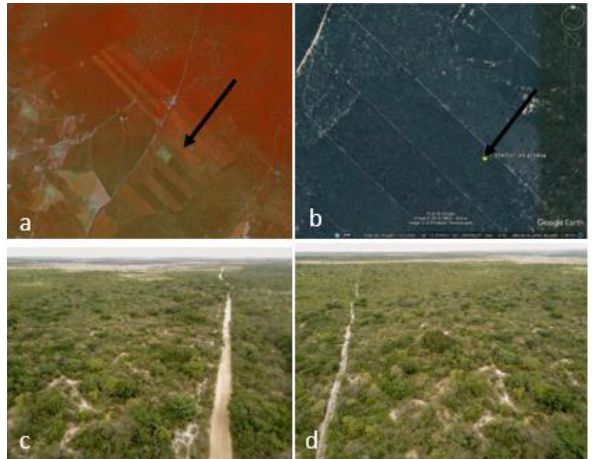
Figure 8. An example of Caatinga native vegetation with some degree of anthropogenic impact according to Landsat image (a) and high-resolution image from GoogleEarth® (b), but